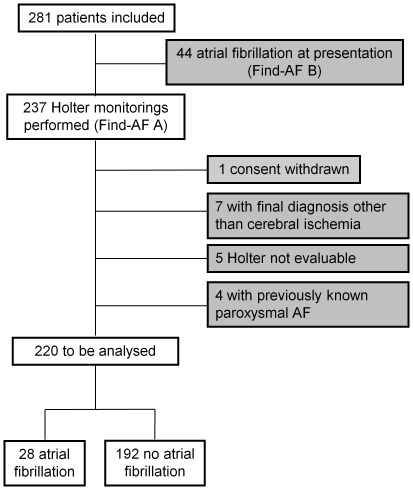
Study flow of the Find-AF trial. 281 patients were included, 237 had sinus rhythm on the admission ECG.1 patient withdrew consent, 16 patients were excluded from the analysis for different reasons, given a total of 220 study participants analysed.